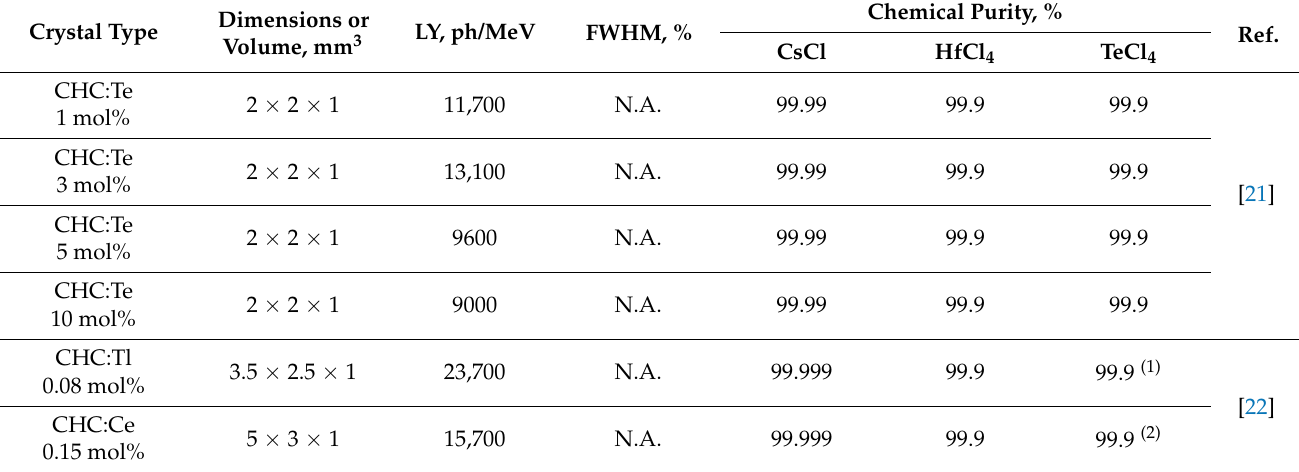
Table 3. List of Cs 2 HfI 6 crystals doped by Te in with different concentrations, Tl and Ce ions, crystal dimensions (or volume) used for their characterization, the relative light yield (LY) and energy resolution (FWHM) measured under irradiation by 662 keV gamma line of 137 Cs source, and chemical purity of corresponding raw materials used for the crystal growth. N.A. means “not